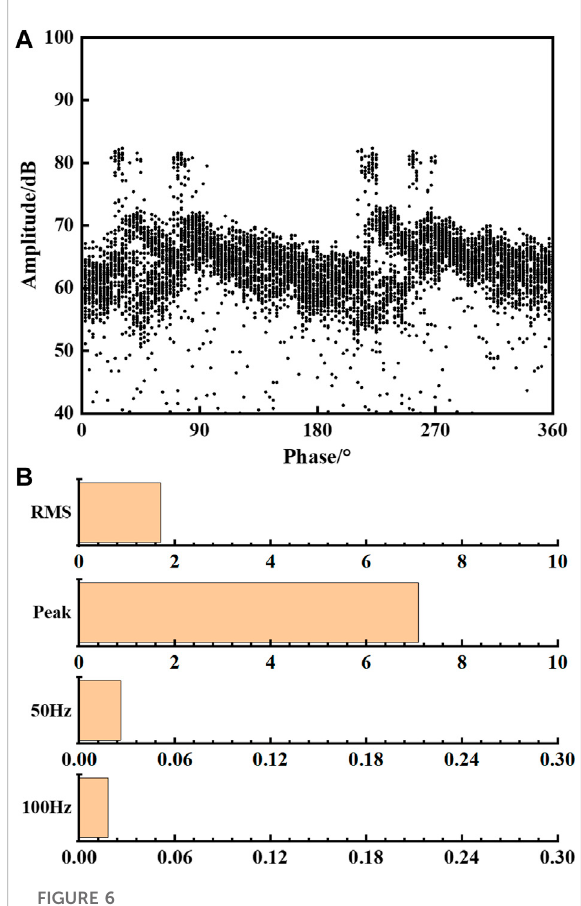
FIGURE 6 AE signals of suspension discharge at 36.17 kV. (A) Periodic mode. (B) Continuous